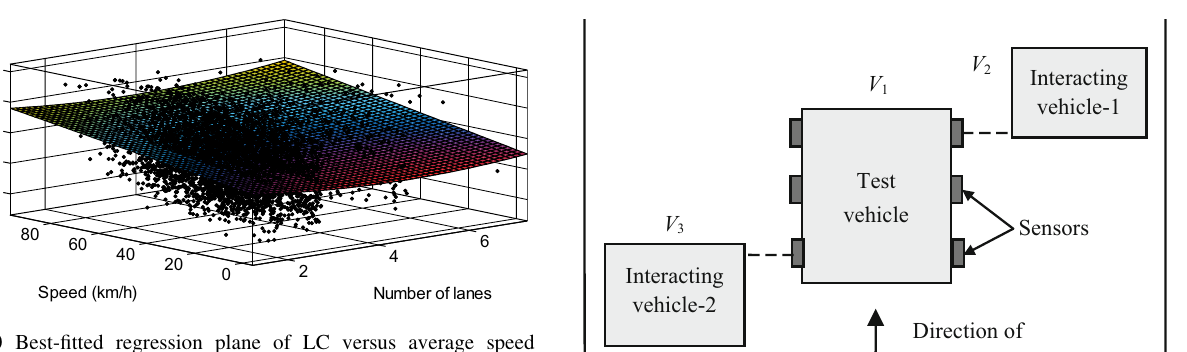
Fig. 10 Best-fitted regression plane of LC versus average speed relationship for pair of vehicles, varying with number of lanes of the road they move upon